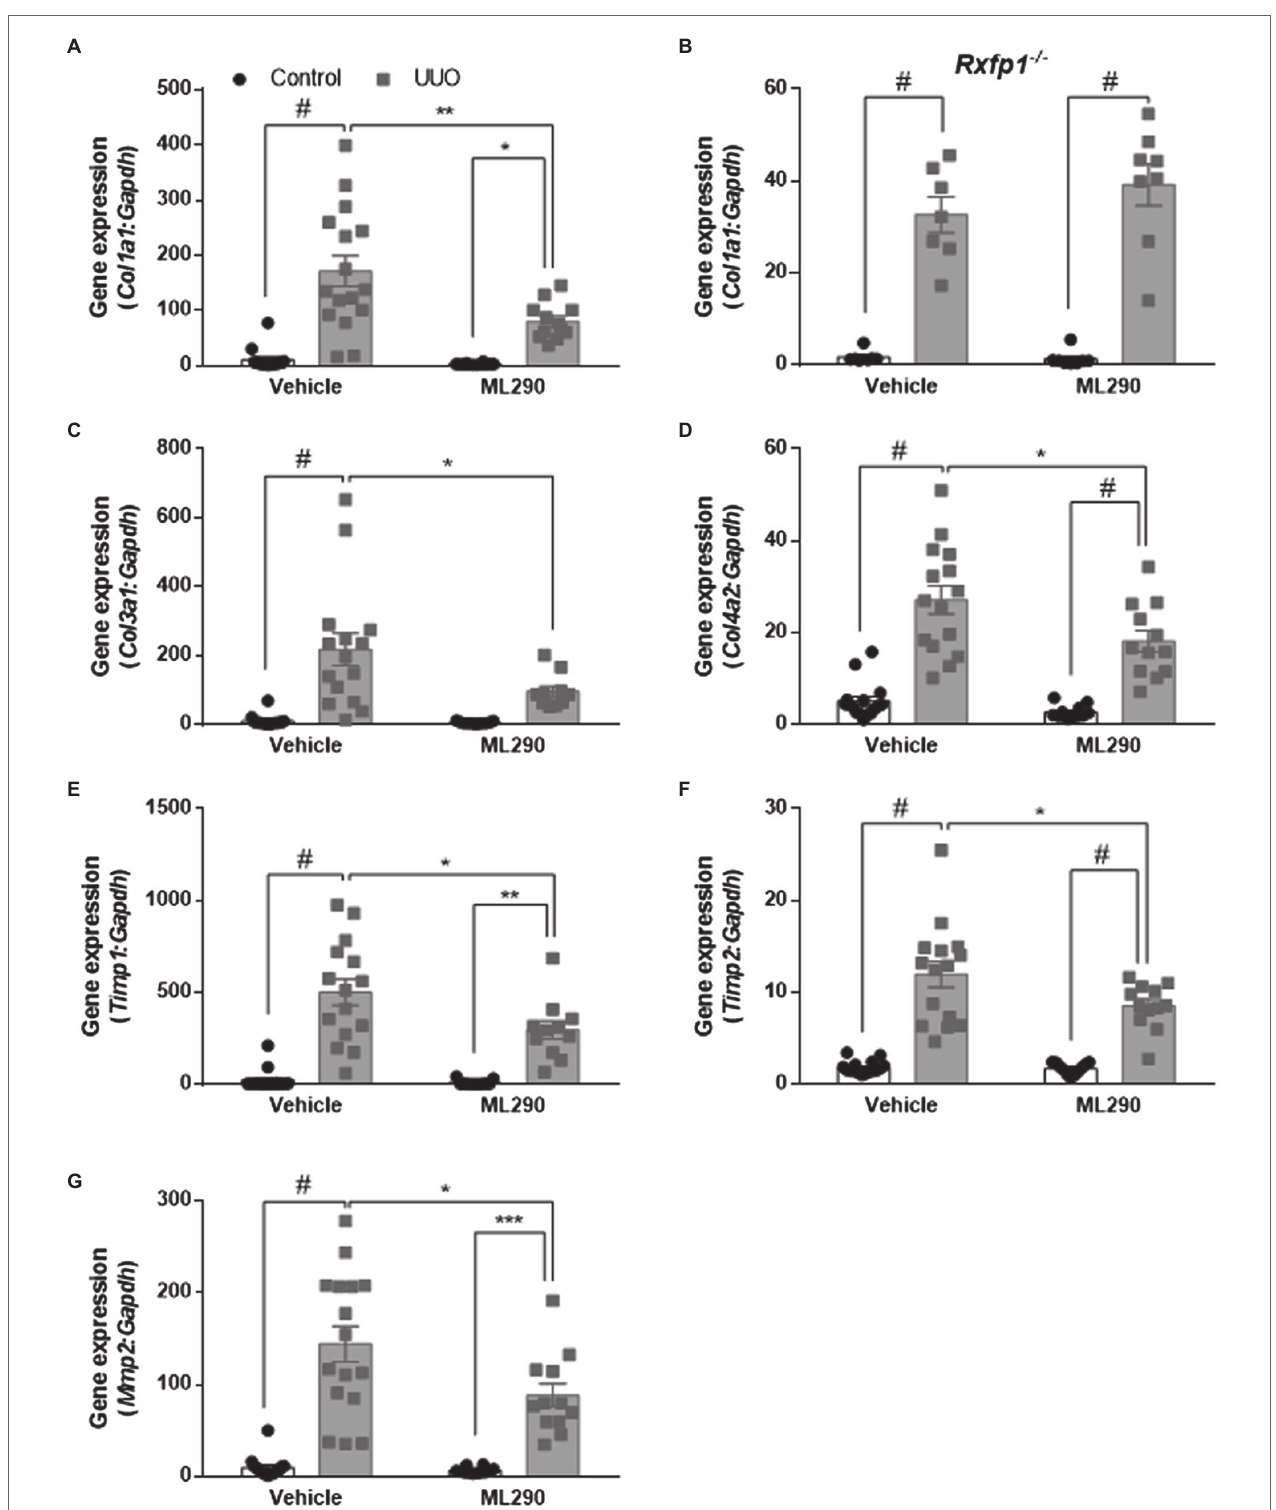
FIGURE 4 | (A,C–G) : Col1a1 (A) , Col3a1 (C) , Col4a2 (D) , Timp1 (E) , Timp2 (F) , and Mmp2 (G) gene expression in the control and UUO kidneys from vehicle- and ML290-treated humanized mice ( n = 12–16 mice/group). (B) : Col1a1 gene expression in the control and UUO kidneys from vehicle- and ML290-treated Rxfp1 - deficient mice ( n = 7–8 mice/group). Gene expression is normalized to the housekeeping gene Gapdh and presented as fold change to control kidneys from vehicle- treated mice. * p < 0.05, ** p < 0.01, *** p < 0.001, and # p <